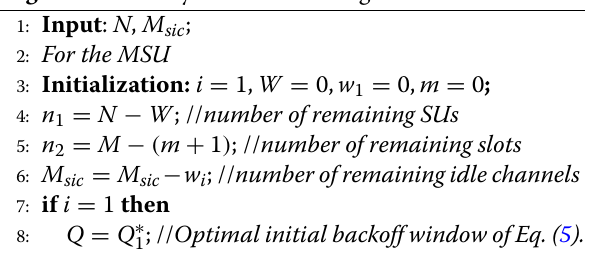
Algorithm 1 Dynamic backoff